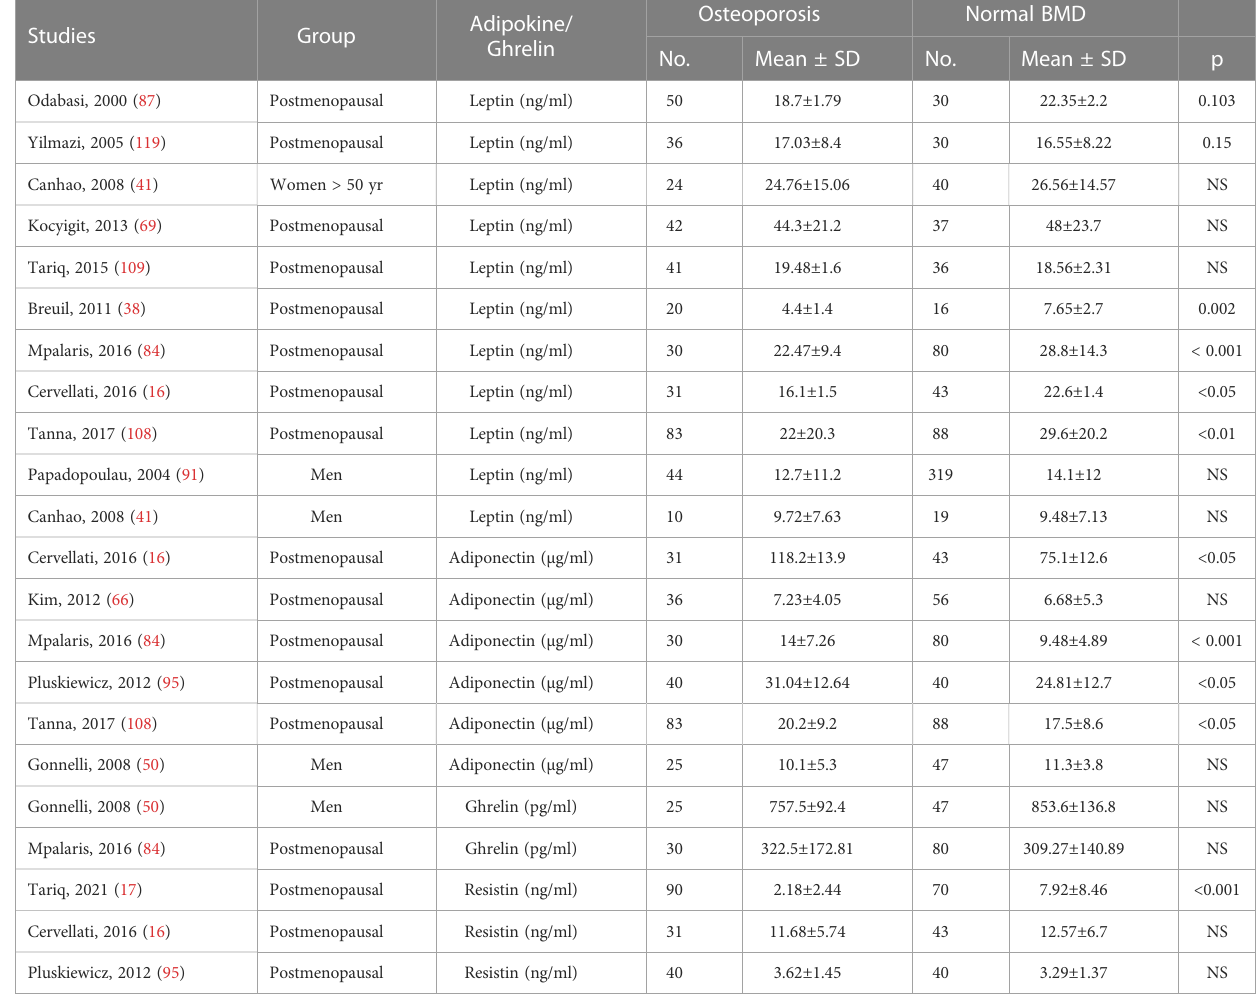
TABLE 4 Differences in adipokines or ghrelin levels according to osteoporosis